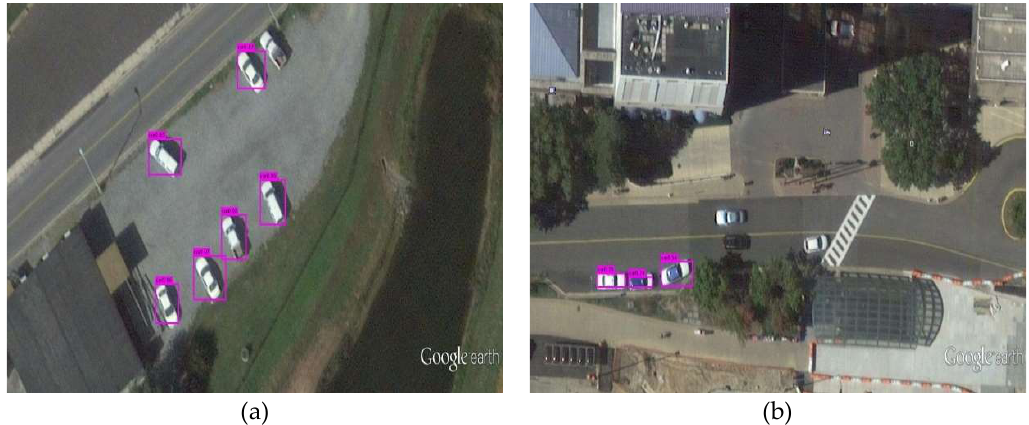
Figure 13. Detection examples for the CAR dataset: ( a ) Example 1; ( b ) Example 2.